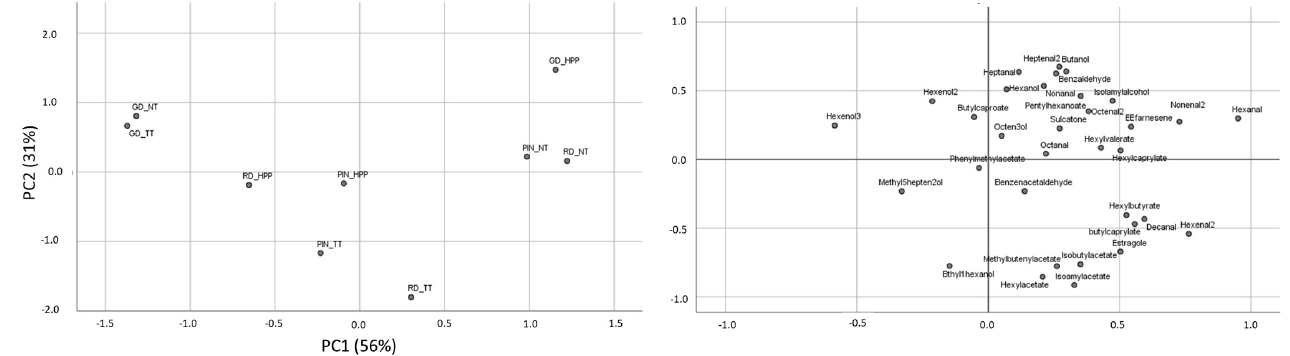
Figure 4. Scatter plot of scores from PC1 vs. PC2, obtained using the concentrations (ppm) of the commonly detected volatile compounds, observed for juice samples, and the relative loadings of the variables used.